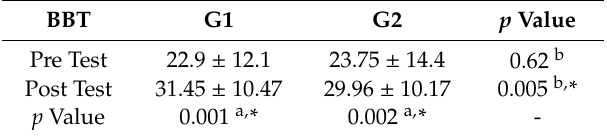
Table 3. The mean values of Box and Block Test (BBT) of a ff ected UL in both groups. BBT